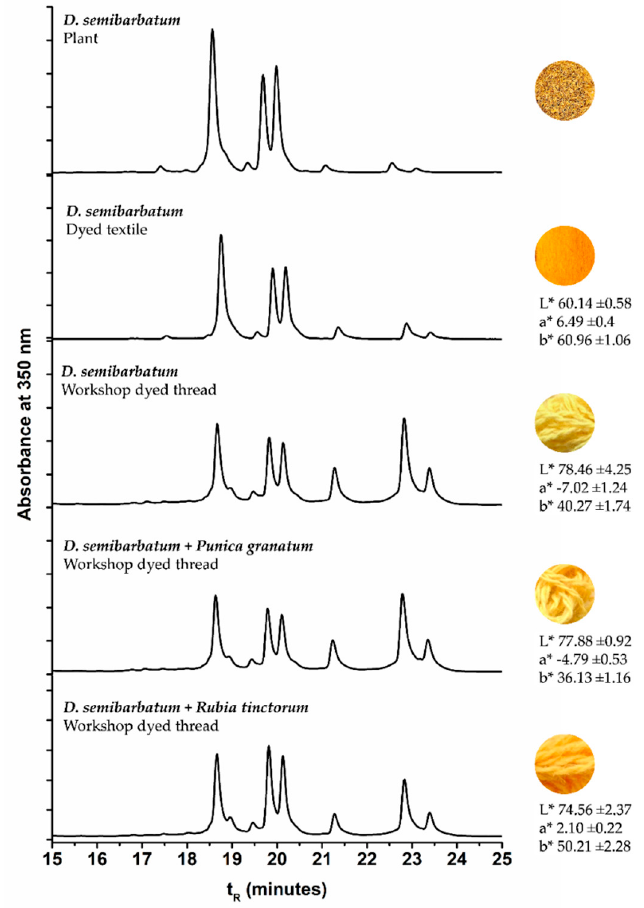
Figure 4. HPLC-DAD profiles for D. semibarbatum extract compared with the extracts from our reference sample and samples acquired at the workshop, together with the L*, a*, b* coordinates.